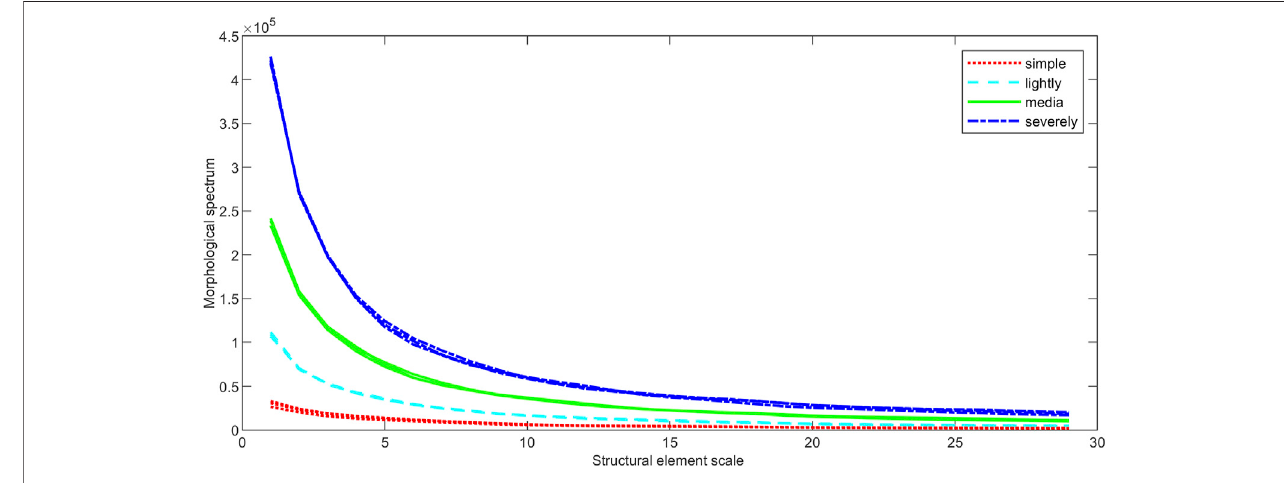
FIGURE 5 | MGS analysis result of line SE.